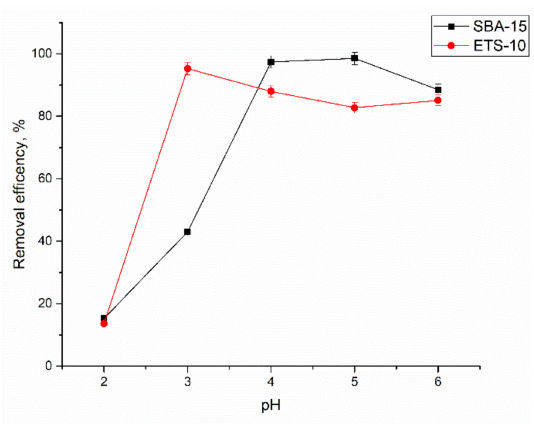
Figure 6. Effect of pH on the adsorption of Ce(III) on analyzed sorbents (C i 10 mg/L, time 1 h, temperature 23 ◦